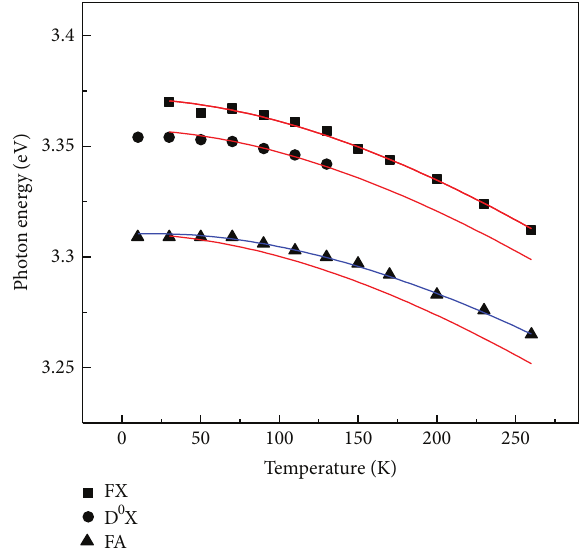
F 6: Temperature dependences on the peak energies of FX( ) emissions for ZnO thin �lms grown on c-Al substrate. e solid lines are the curves �tted by formula (2). ▴ the intensity of the FA, and FA-LO bands gradually becomes strong with increase temperature. At 130 K, four evident emission peaks labeled FX, D X, FA, and FA-LO are located at 3.360 eV, 3.346 eV, 3.301 eV, and 3.227 eV, respectively. 0